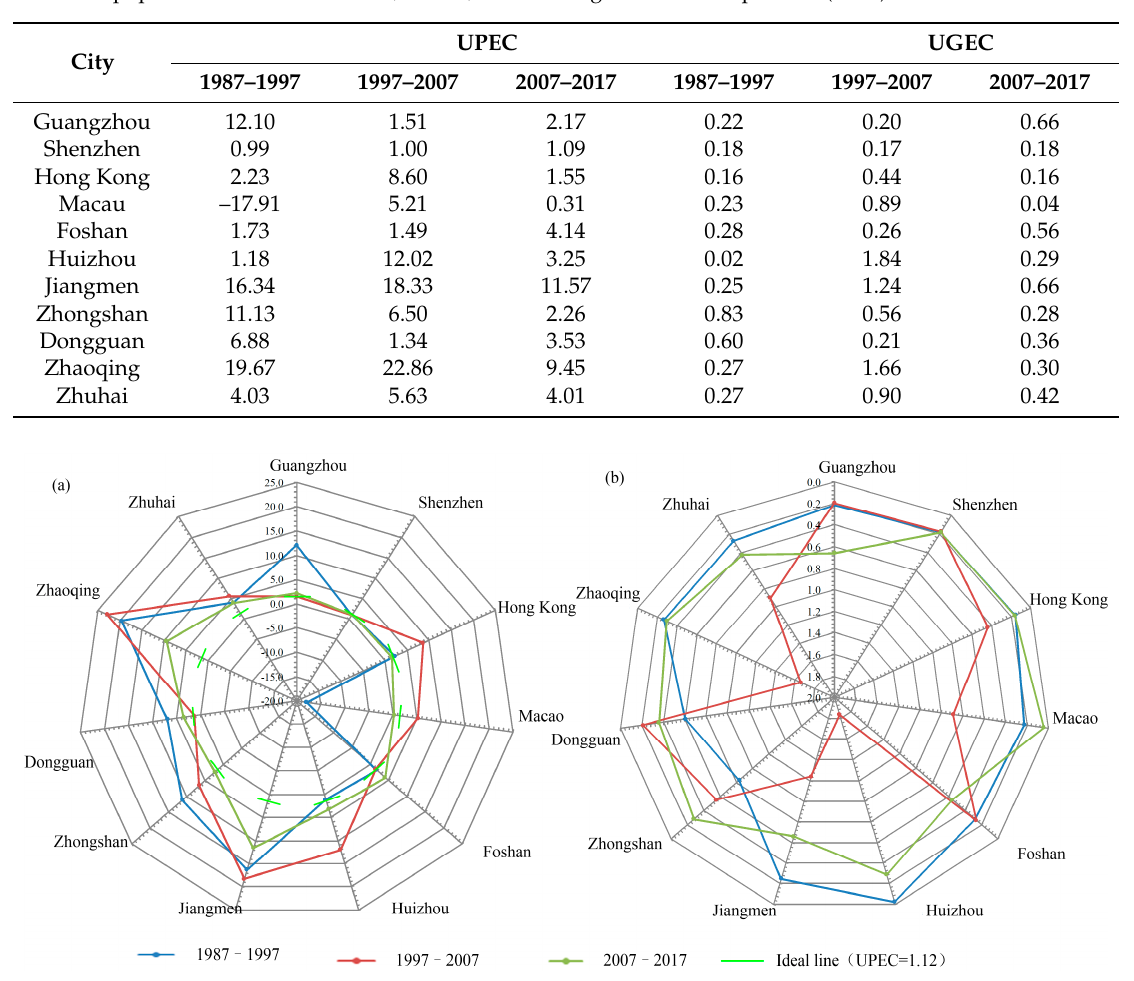
Figure 9. The rationality of urban expansion in 11 cities in the GBA between 1987 and 2017: ( a ) urban area population elastic coefficient (UPEC); and ( b ) urban area gross domestic product (GDP) elastic coefficient (UGEC). The farther the UPEC value deviates from the ideal line, the worse the rationality of urban expansion.